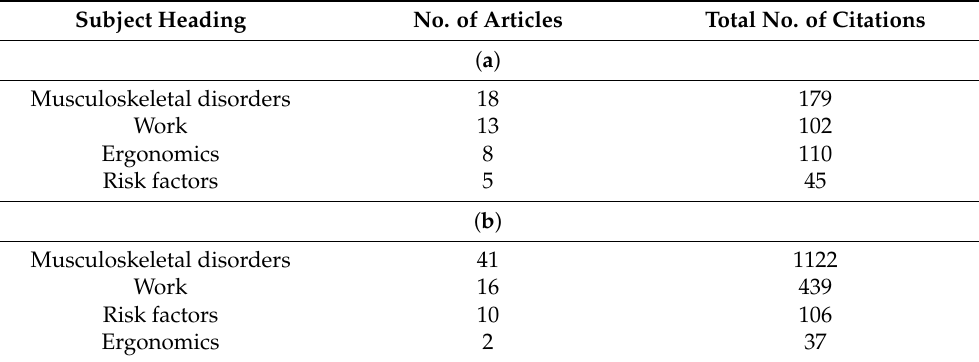
Table 4. (a) Number and citations of research articles as per subject-wise analysis concerning RULA, (b) number and citations of research articles as per subject-wise analysis in regard to